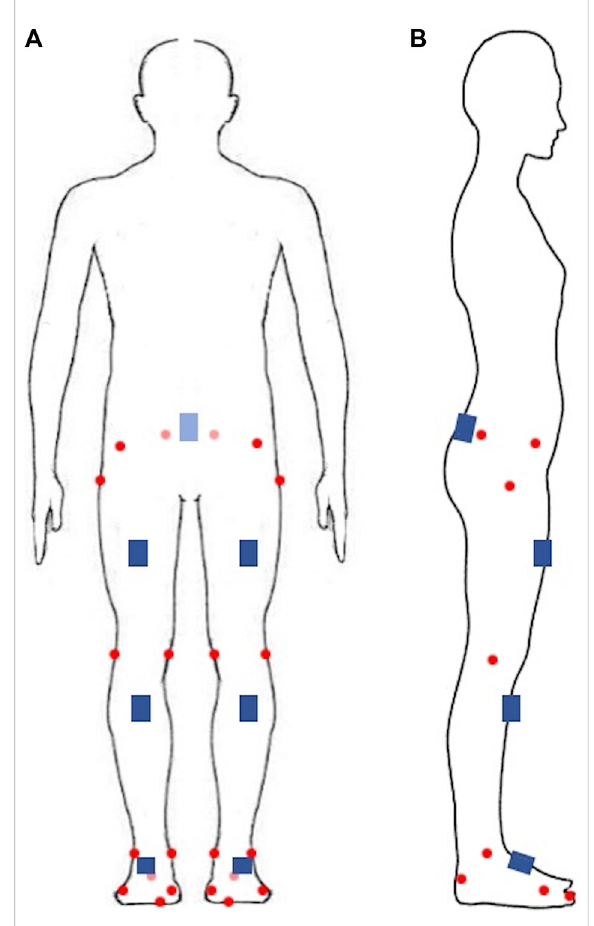
FIGURE 2 The retrore fl ective markers and inertial measurement units ’ attachment site. (A) front view; (B) side view. Red circles represent retrore fl ective markers, blue squares represent inertial measurement